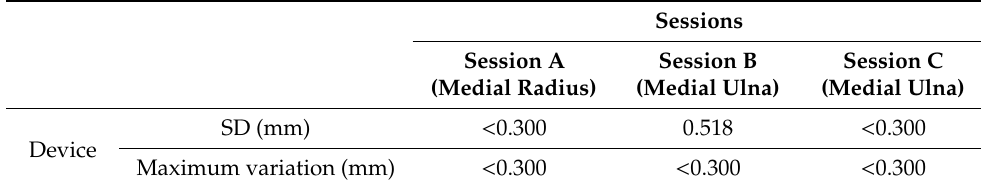
Table 1. Values of the mean displacement signal for the two environmental markers located on the device during the three acquisition